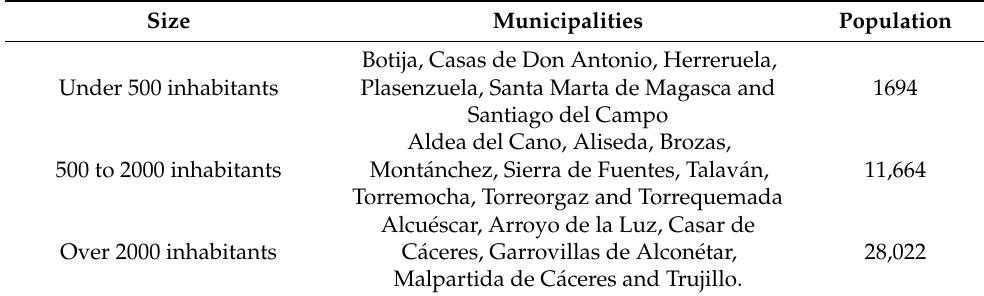
Table 1. Population groups of